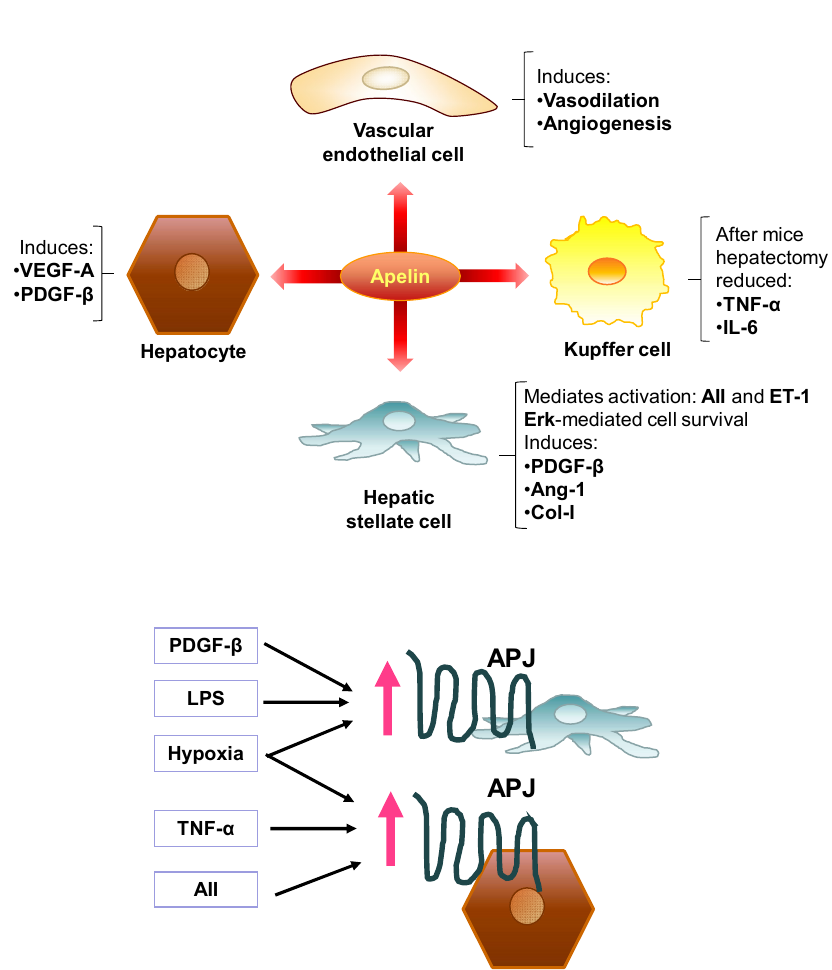
Figure 6. Overview of the roles of the apelin system in liver fibrosis.